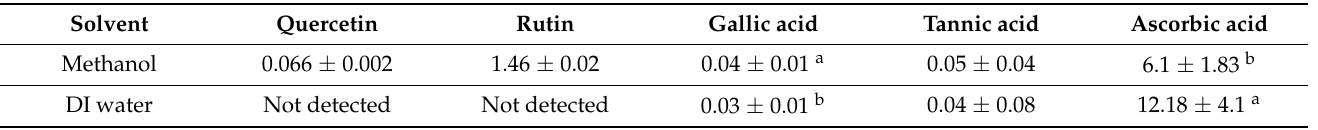
Table 3. Quercetin, rutin, gallic acid, tannic acid, and ascorbic acid in methanol and water of A. garckeana fruit (µg/g DW).